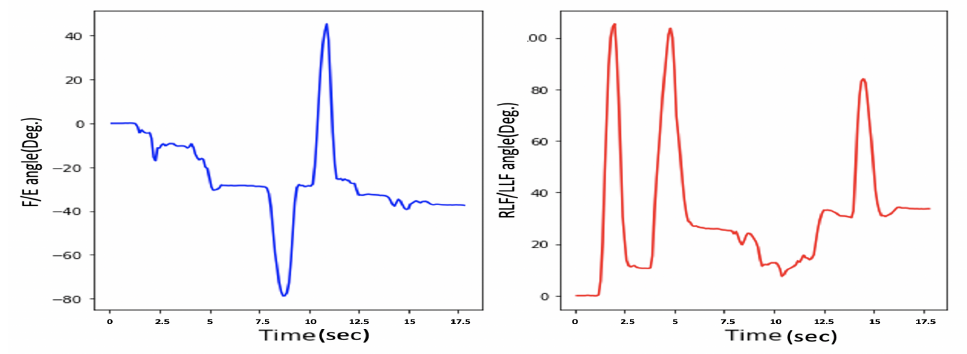
Figure 9. Drift problem in only